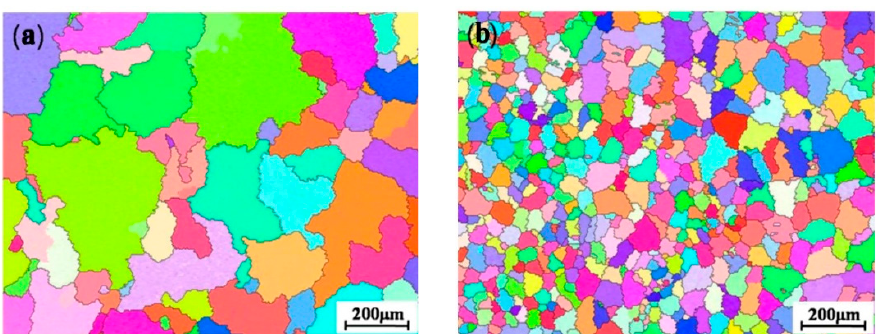
Figure 3. An example showing the powerful effect of grain refinement with Zr on Mg alloy. Electron backscattered diffraction technology (EBSD) image of: ( a ) Zr-free WE54 alloy; ( b ) Zr-containing WE54 alloy. Poured at 780 °C into a steel mold (300 °C). Reprinted with permission from ref. [44]. Copyright 2013 Elsevier.